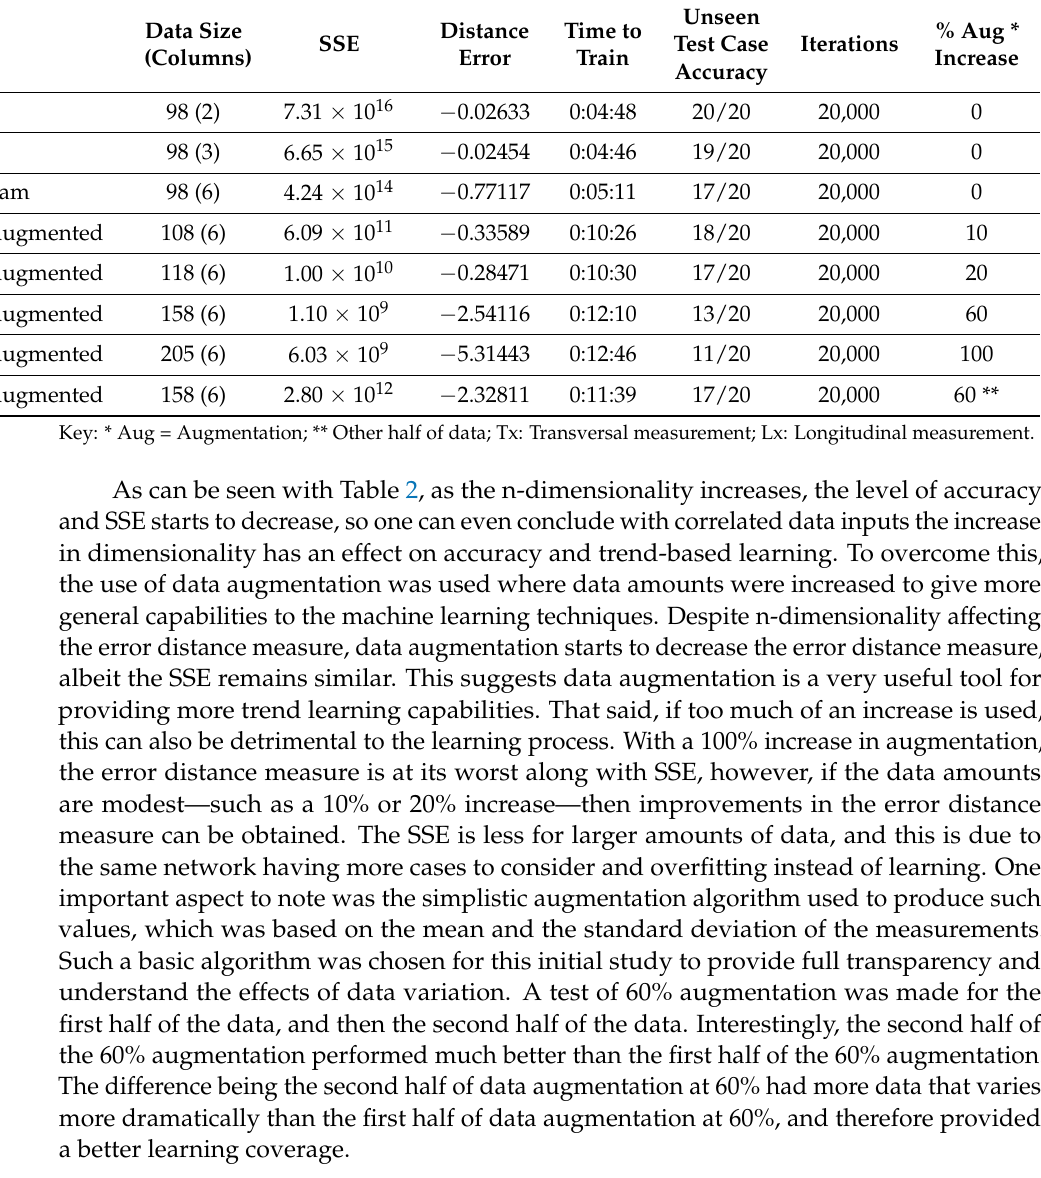
Table 2. Neural Network results for normal data and different levels of dimensionality and